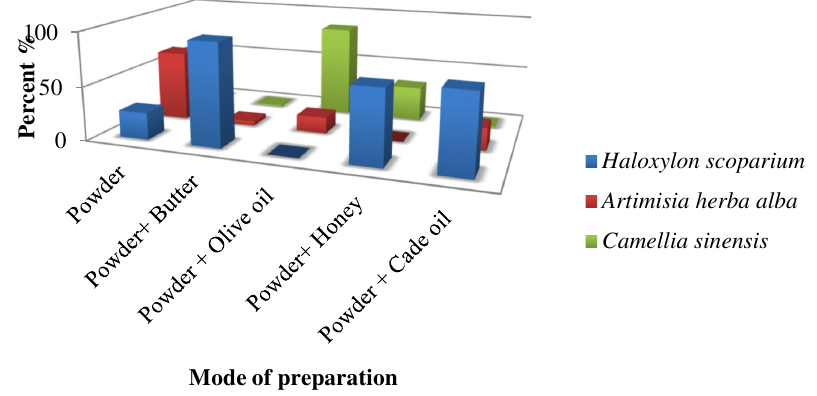
Figure 5. Methods of preparation of plant-based medicines using Haloxylon scoparium , Artemisia herba- alba , and Camellia